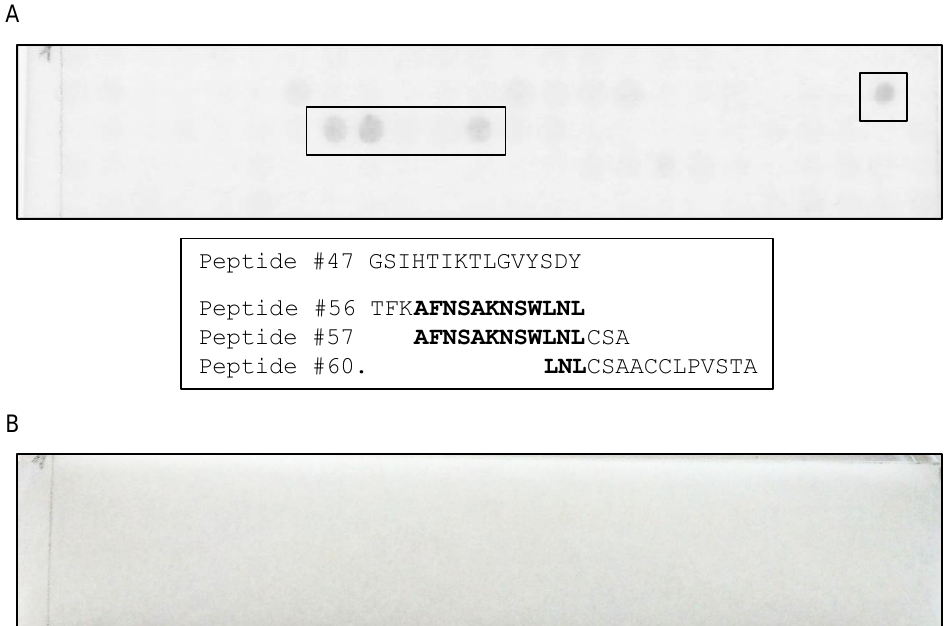
Figure 4. A cellulose membrane, containing 372 15-mere peptides covering the whole F13 protein, was used for epitope mapping. The scFv 3E2 ( A ) reacted with four peptide spots (No. 47, 56, 57 and 60). Two targets were mapped (139-GSIHTIKTLGVYSDY-153 and 166-TFKAFNSAKNSWL NLCSAACCLPVSTA-192). The minimal sequence essential for binding for the second epitope area was 169-AFNSAKNSWLNL-188. The secondary Ab, used as a negative control ( B ), did not bind to any spots.